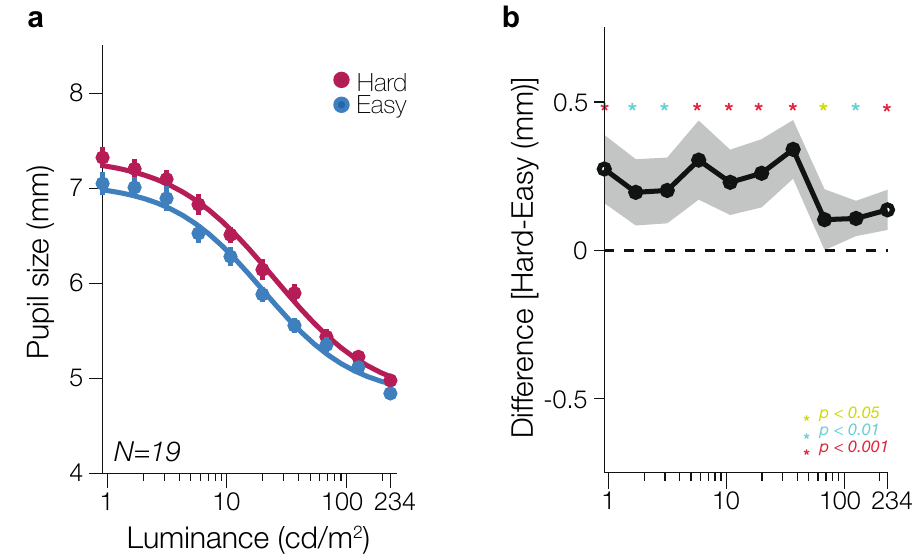
Figure 4. Group results. ( a ) Group-level mean pupillary light reflex function for the Hard and Easy condition fitted with the modified Naka-Rushton function. Error bars represent SEM. Overall, greater pupil size is observed in the Hard condition compared to the Easy condition across all ten luminance levels. ( b ) To test for significance between the pupil size in the Hard and Easy conditions, the difference in pupil size was taken between the Hard and Easy condition for every observer at every luminance level. Group-averaged pupil differences across all ten luminance levels were then calculated. The shaded gray area represents the 95% confidence